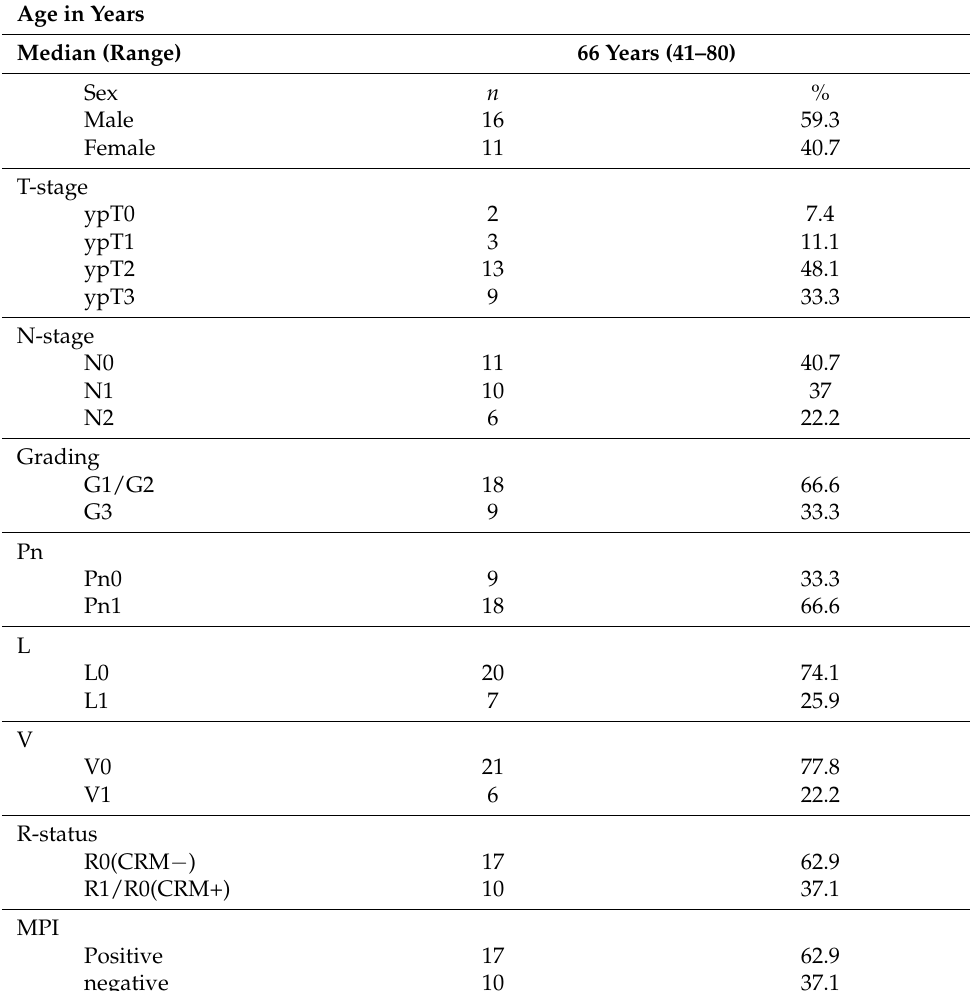
Table 1. Demographic table of all 27 patients of the neoadjuvant cohort. Staging is revised to the 8th Edition of the UICC TNM classification of malignant